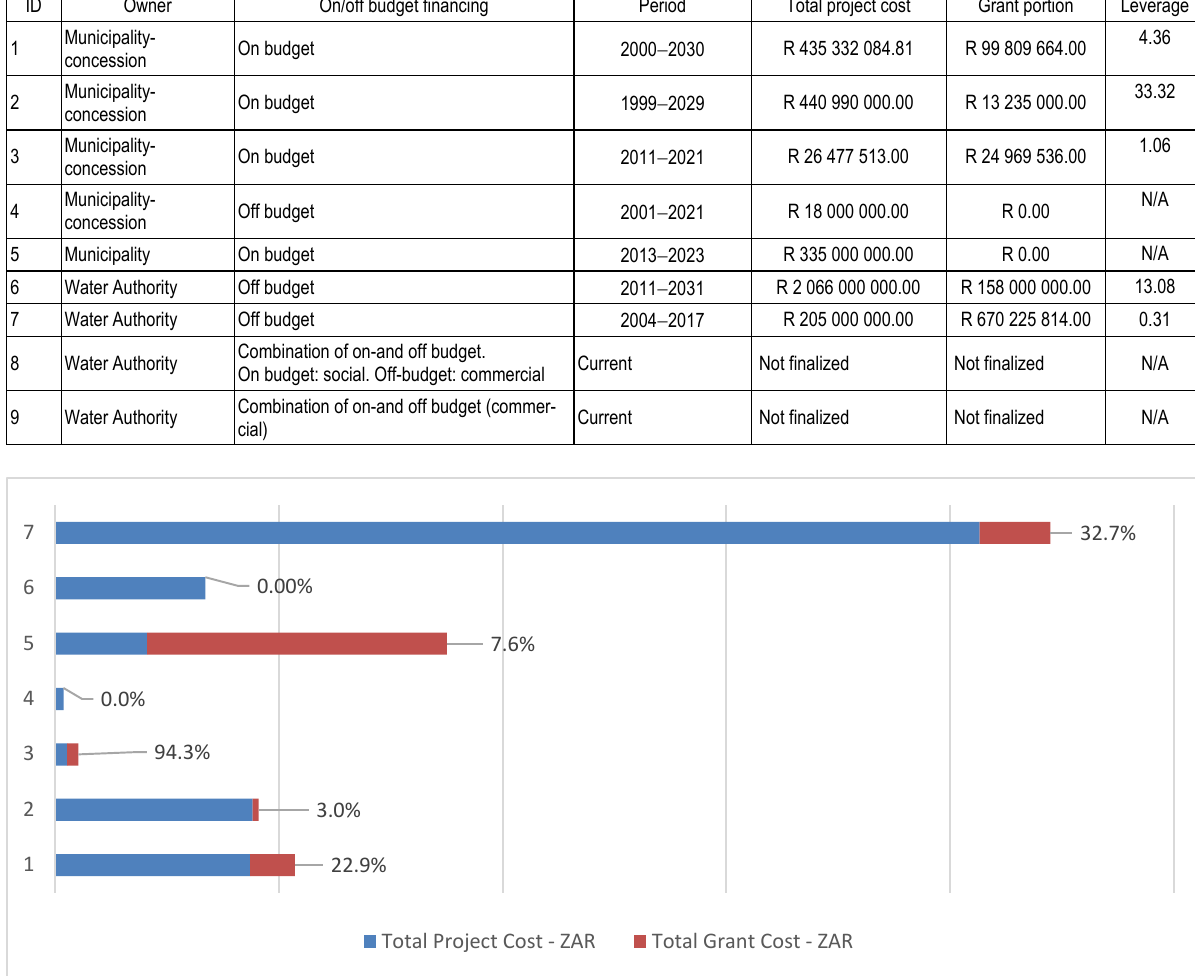
Figure 6. Proportion of grant cost as per total cost of the South African project sample where financing had been